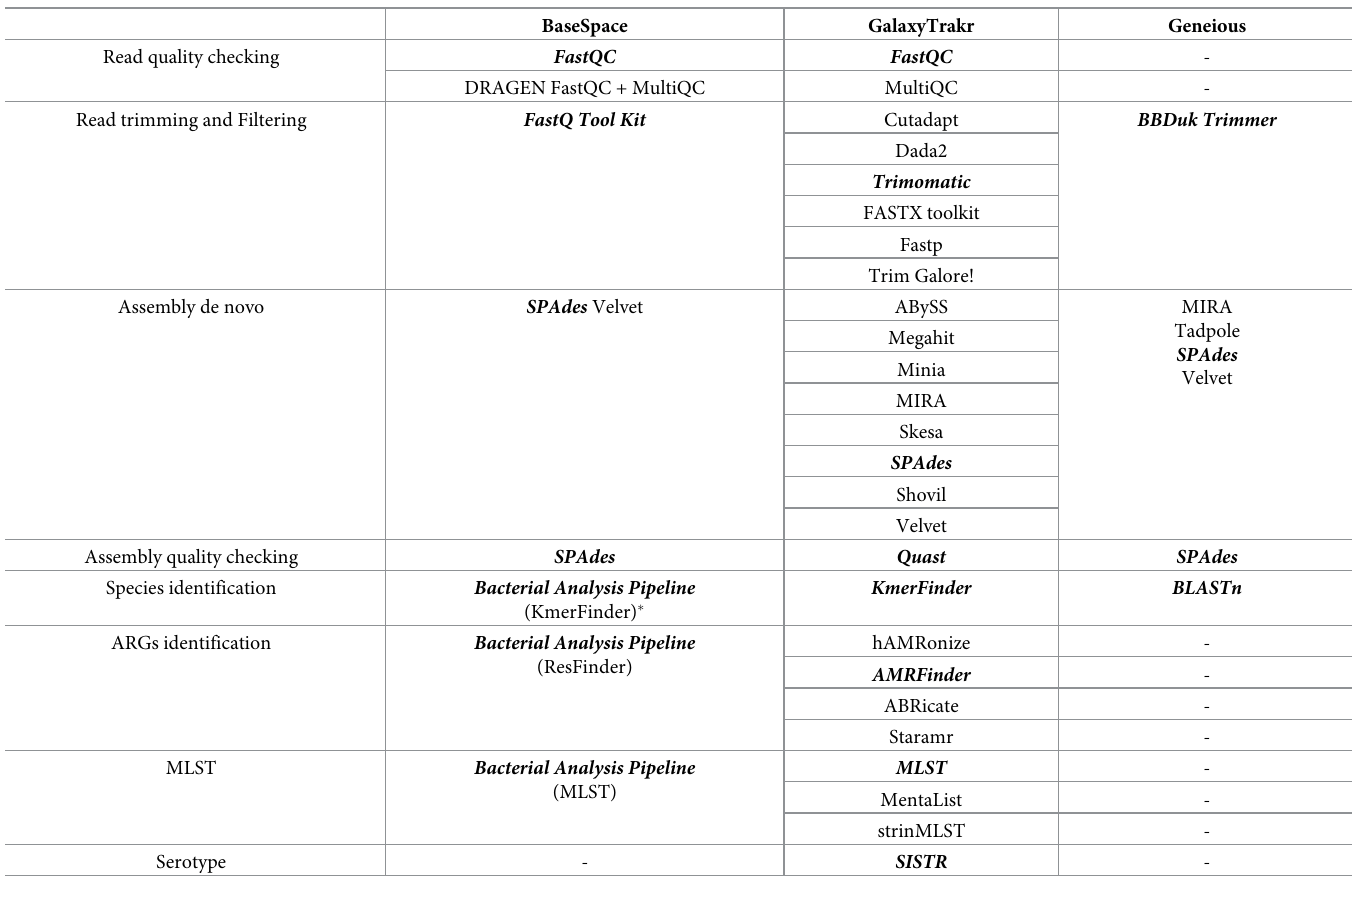
Table 4. List of some available programs and tools in each user-friendly